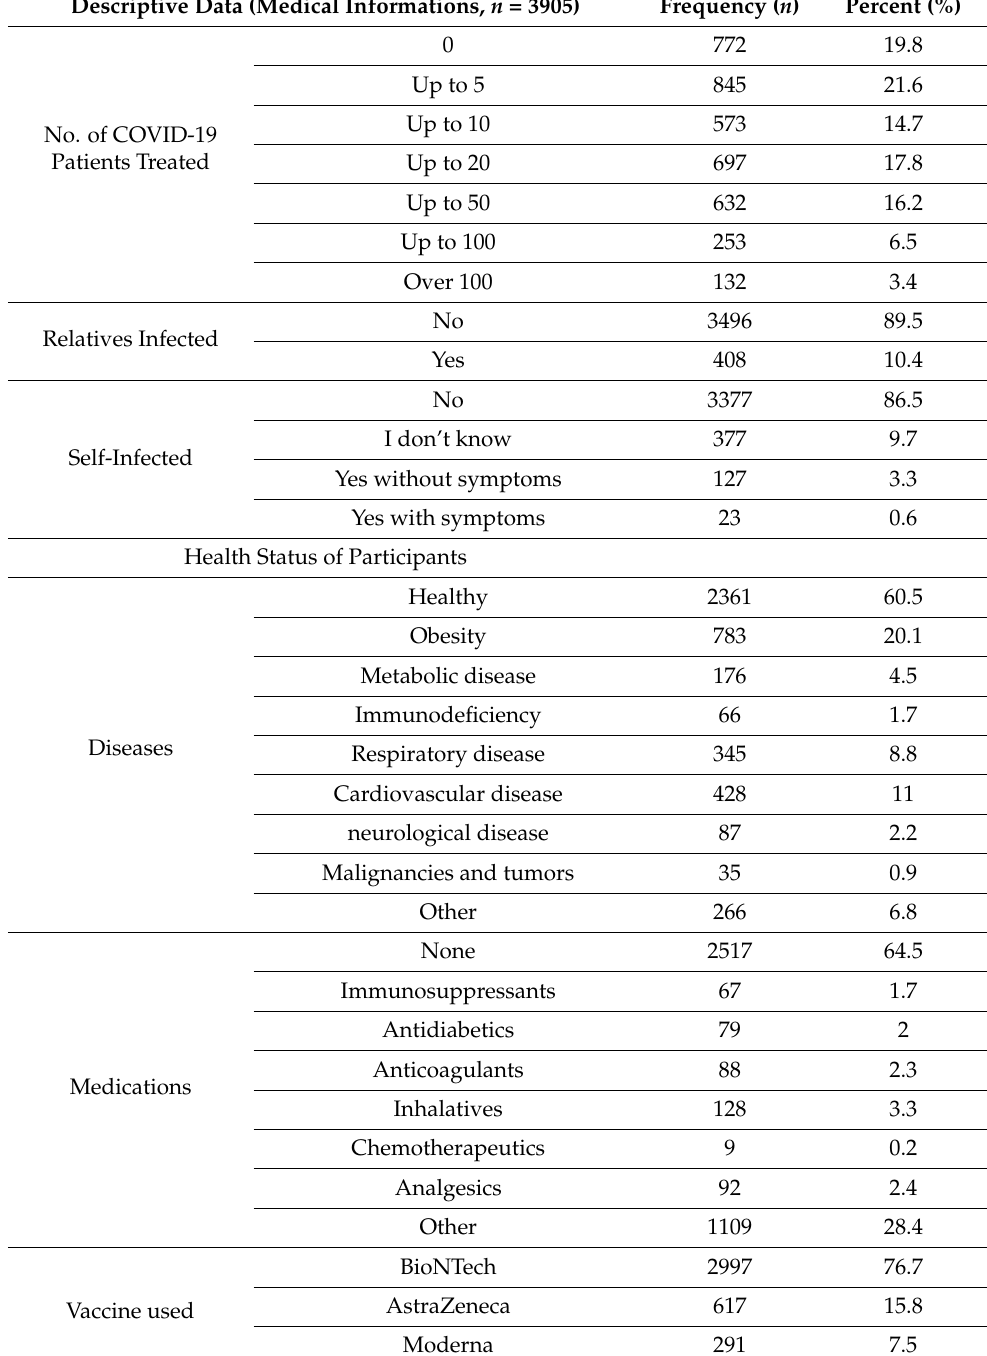
Table 2. Descriptive data with medical